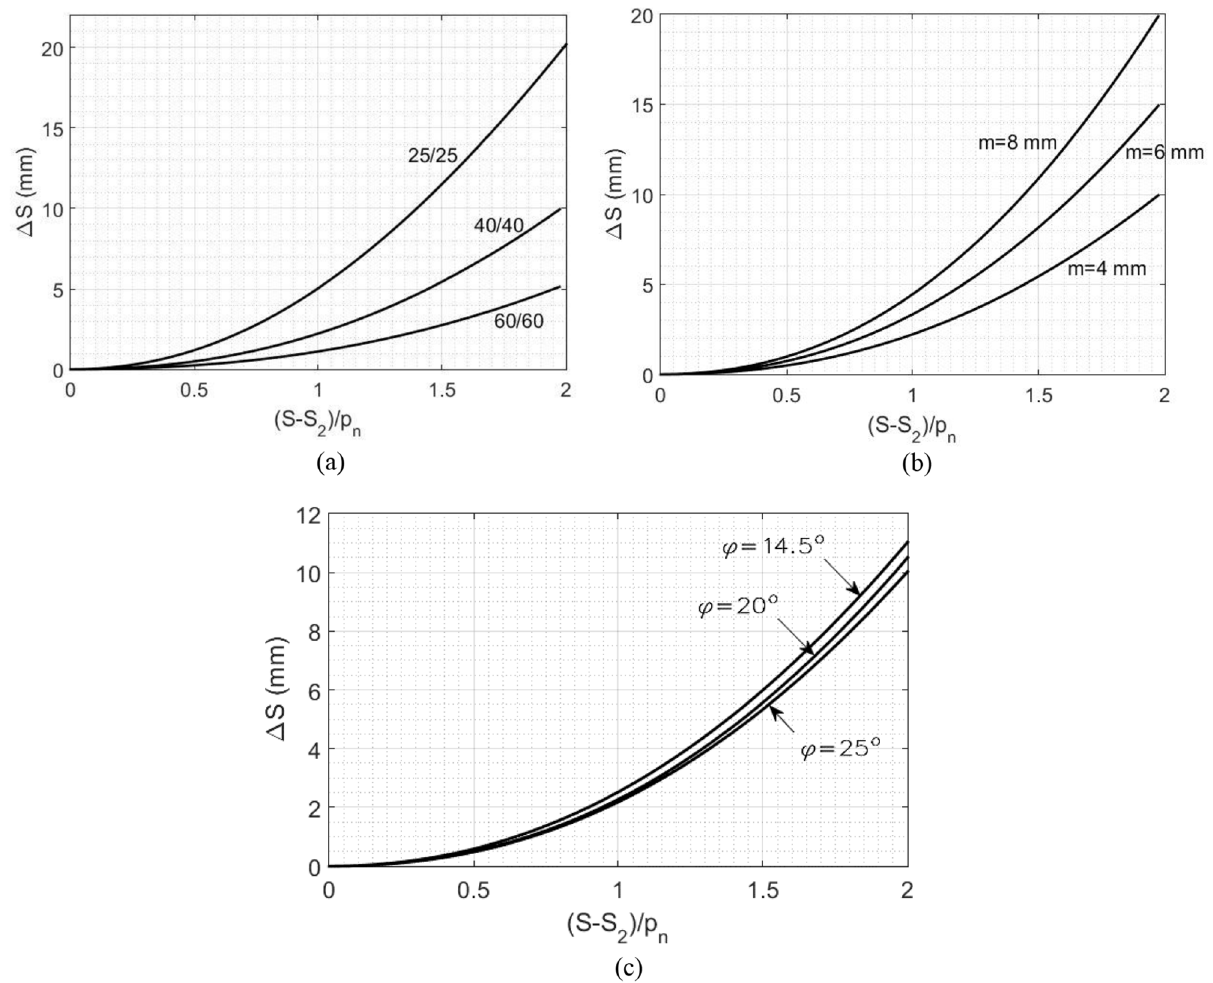
Fig. 3. Effects of the gear parameters on the variation of the separation distance D S